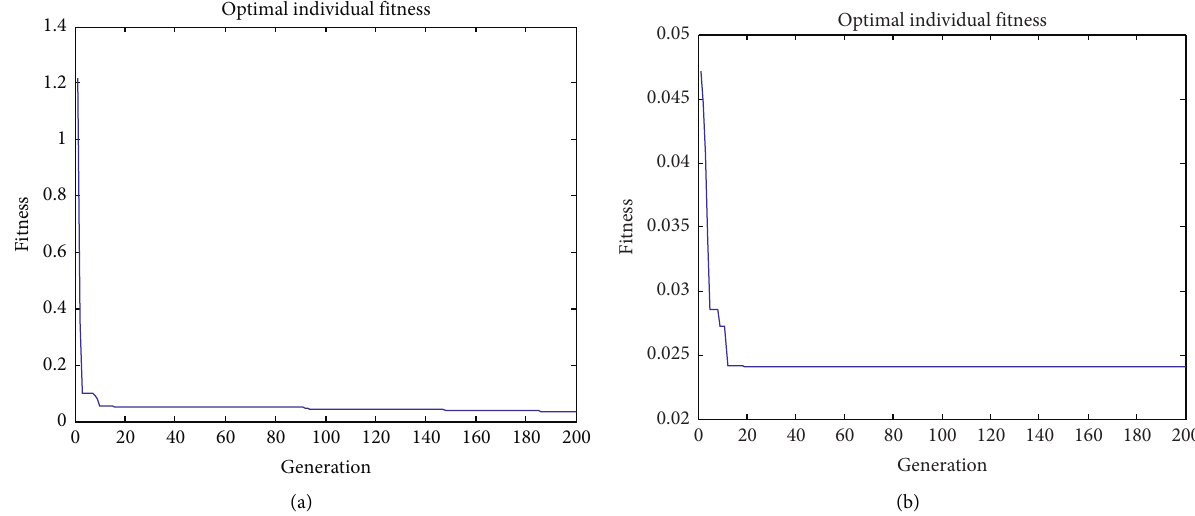
Figure 3: Iterative optimization of the fitness function. (a) The fitness function of optimization under harmonic excitation. (b) The fitness function of optimization under random